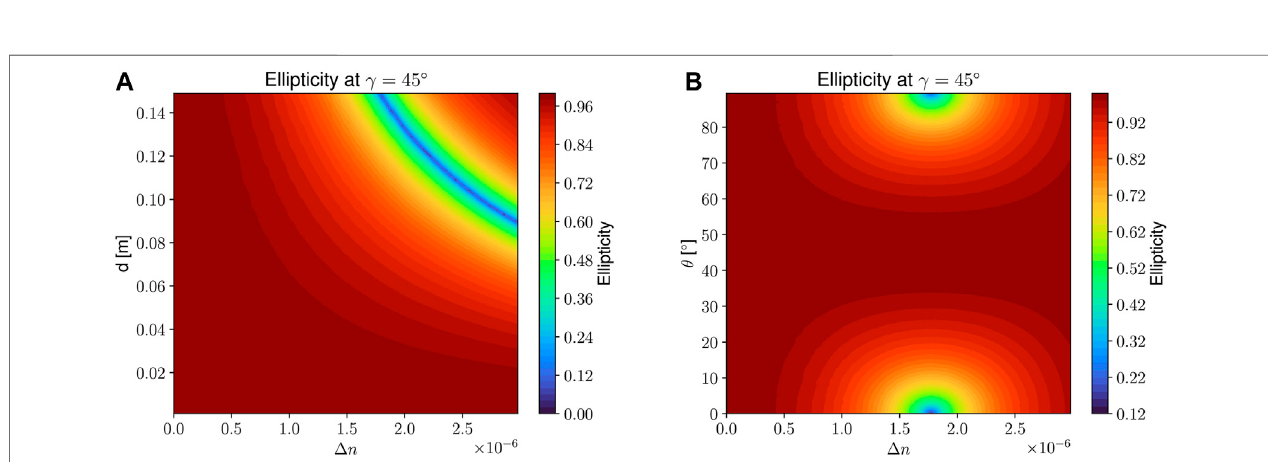
FIGURE6| Ellipticityoftheexiting fi eldasafunctionofsample-thicknessand Δ n (A) ,and θ and Δ n (B) ,respectively.Theinputpolarizationislinearwith γ =45 ° and α = 0 ° inclination.